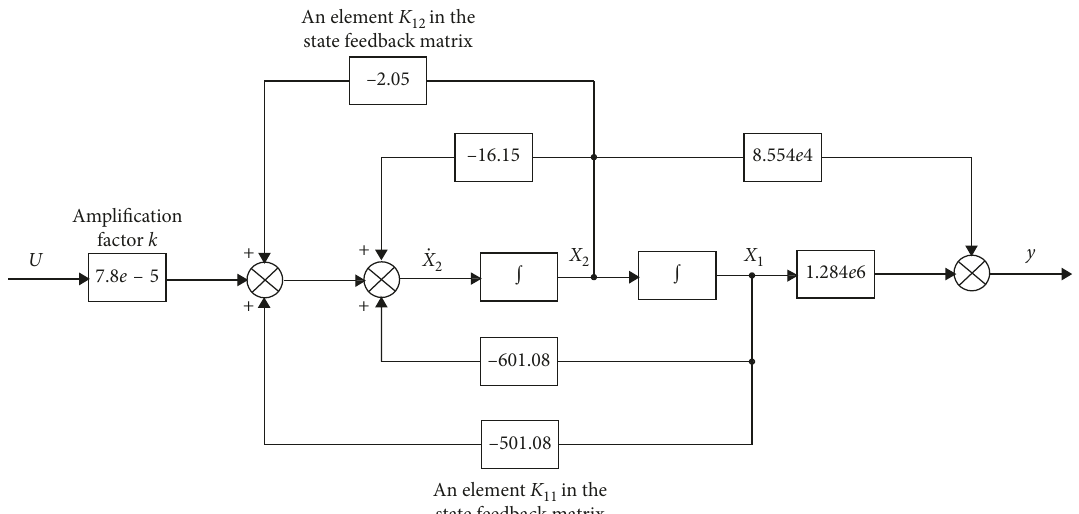
Figure 6: The block diagram of the control system after the pole assignment.